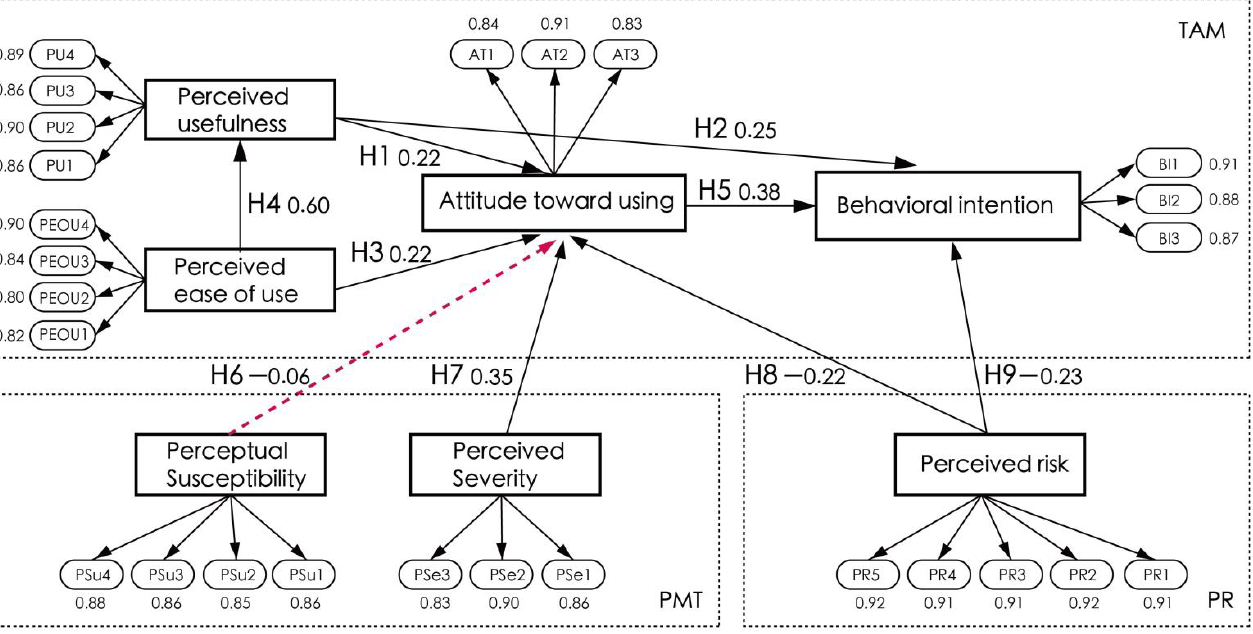
Figure 3. Hypothesis path coefficient diagram.